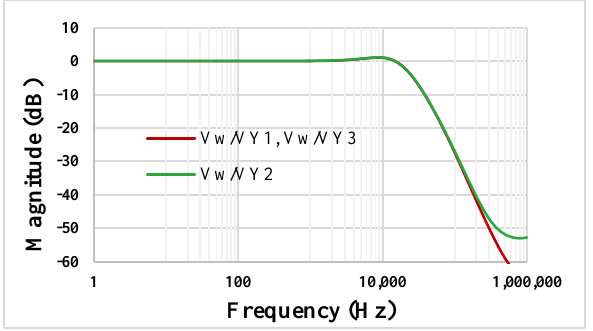
Figure 6. The magnitude characteristics of the DDCC.